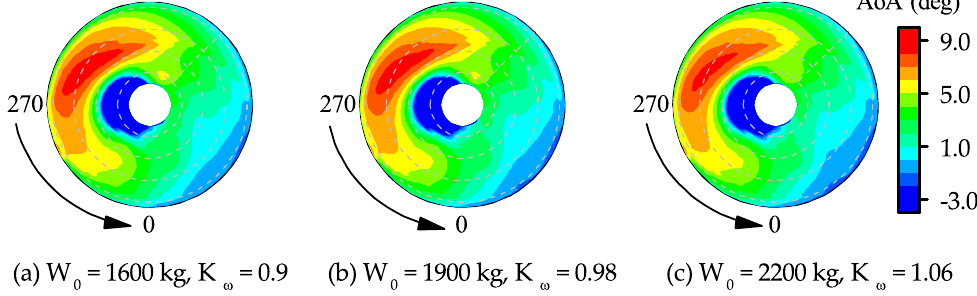
Figure 9. µ = 0.3, AoA with rotor